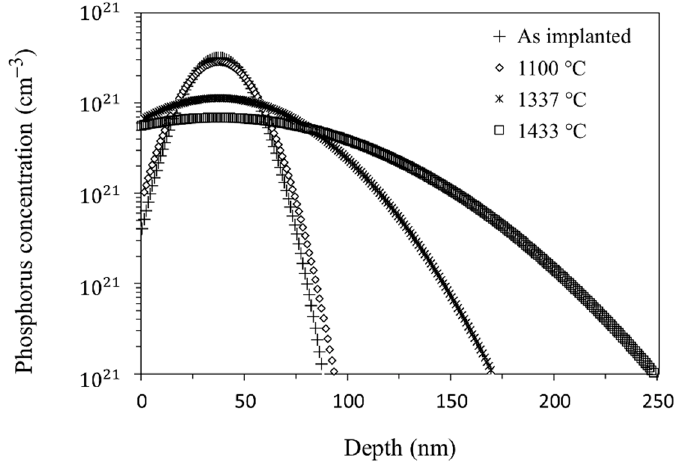
Figure 7. Phosphorus concentration distributions obtained at different temperature conditions.